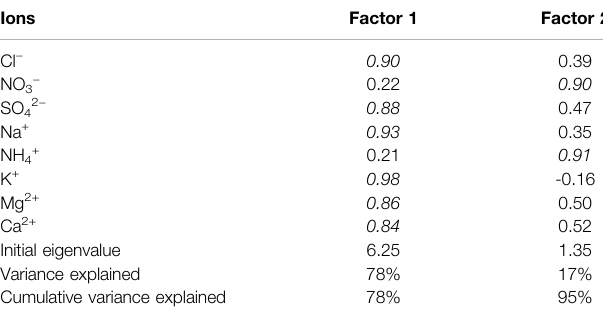
TABLE 2 | Rotated component matrix for soluble ions in aerosol